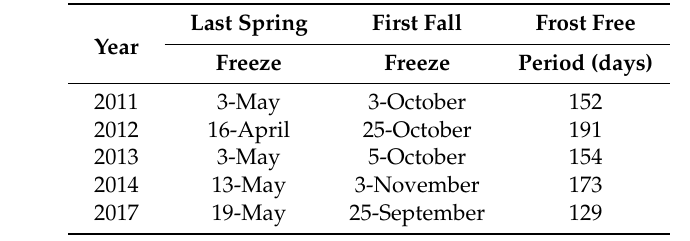
Table 2. Last spring and first fall freeze dates and the frost-free period during the five maize growing seasons, ASC Farmington, NM.